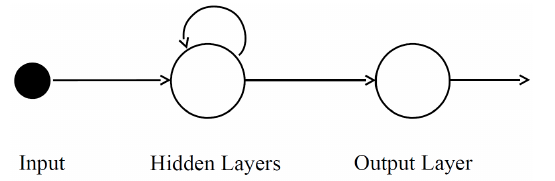
Figure 5. Recurrent Neural